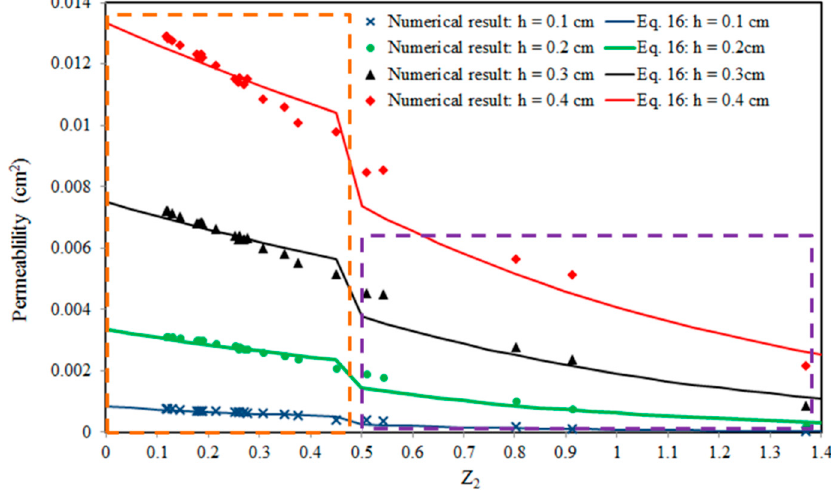
Figure 12. Comparison between numerical results and proposed equation.